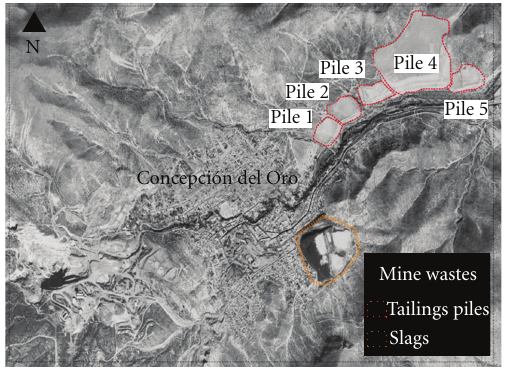
Figure 2: Mine tailings piles at Concepci´on del Oro. Location of the tailings piles at the Concepci´on del Oro mining area (North-Central Mexico) and Pile 2 from where the sample was taken.